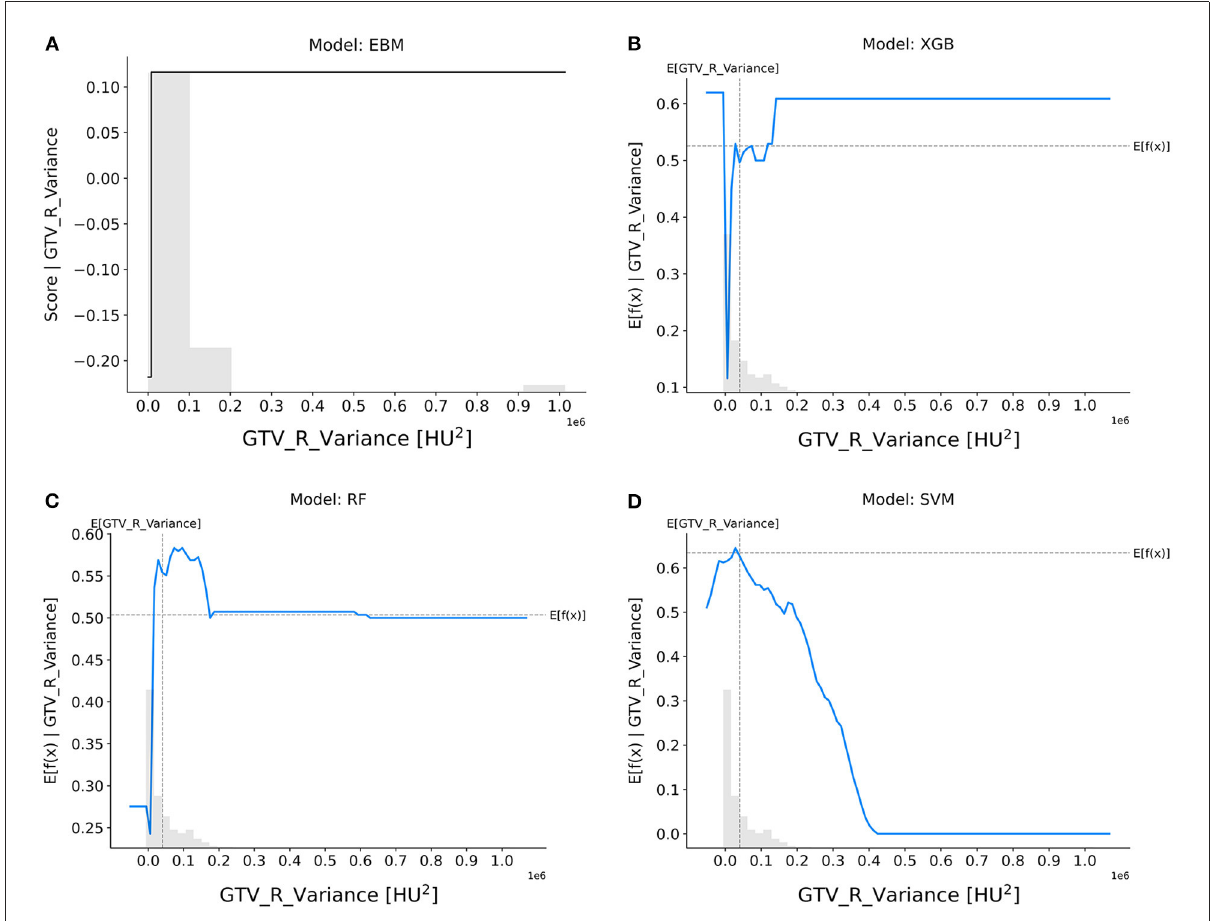
FIGURE5 Response score plots for GTV_R_variance. (A) EBM shape function and SHAP partial dependence functions for the (B) XGB, (C) RF, and (D) SVM